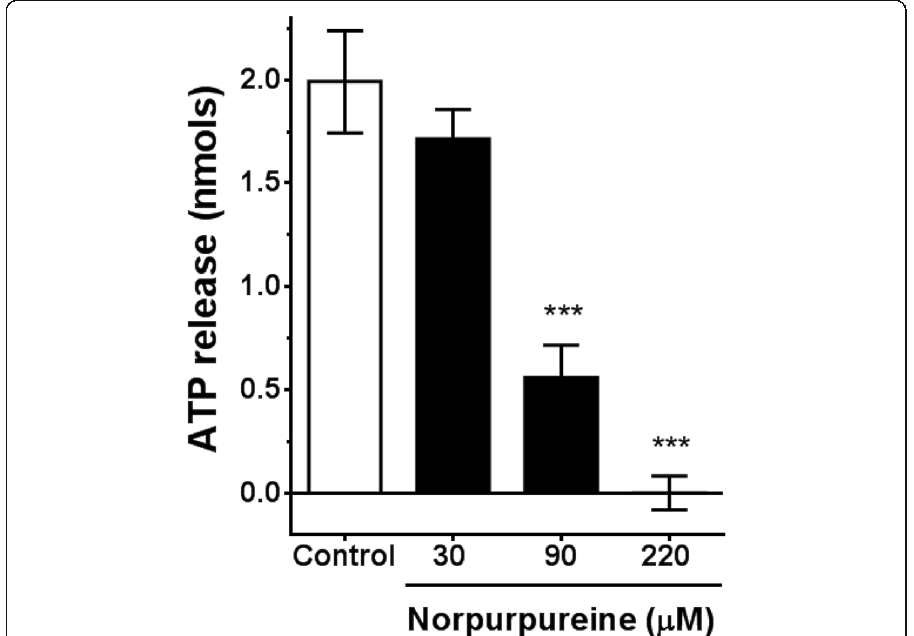
Fig. 4 Norpurpureine inhibits platelet secretion. Platelets were stimulated with 10 μ M ADP in the absence or presence of the indicated concentrations of norpurpureine. The amount of ATP released was quantified from the bioluminescence of the ATP – luciferin/luciferase reaction. The ATP standard calibration curve was used for quantification of the nucleotide. The data are the means ± SD ( n =3, done in triplicate), p <0.001 (***) vs.